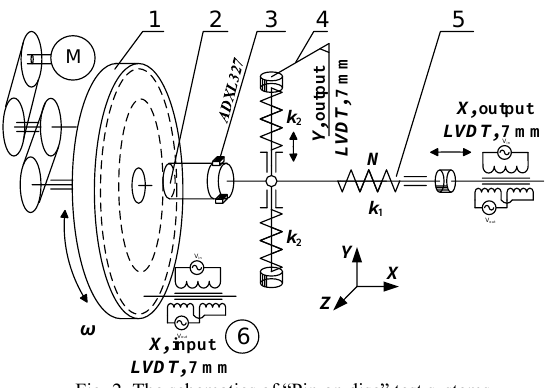
Fig. 2. The schematics of “Pin on disc” test systems.